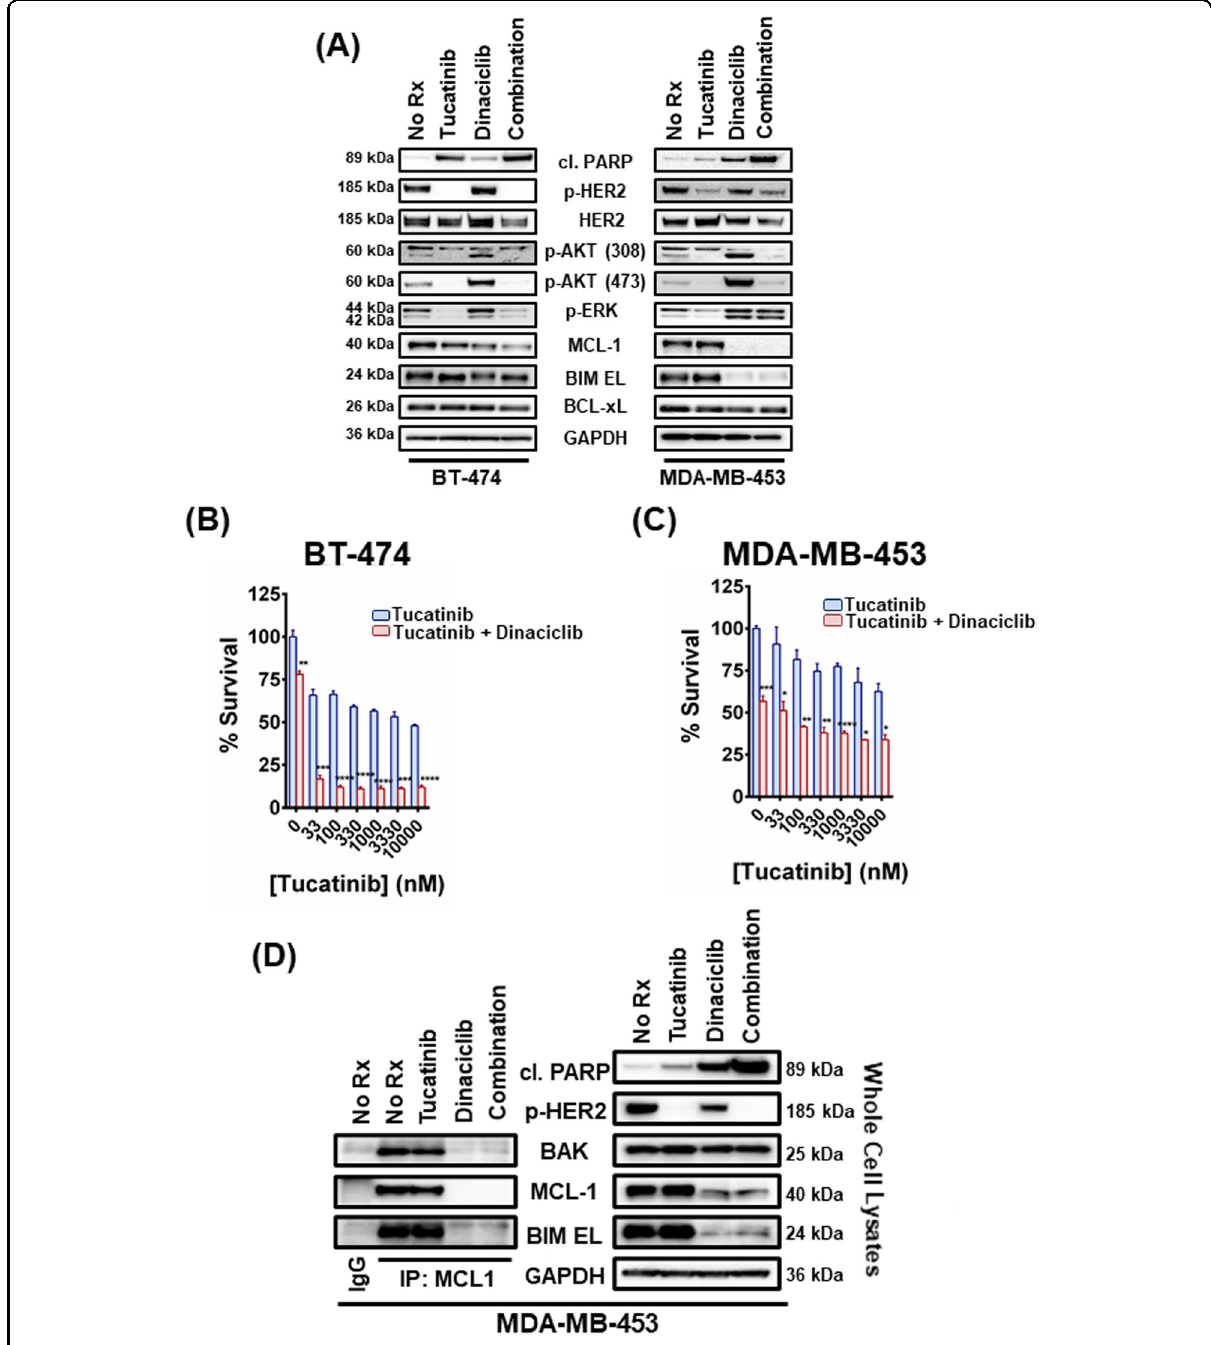
Fig. 3 Dinaciclib sensitizes HER2 -ampli fi ed breast cancer cells to tucatinib and liberates BAK from MCL-1. A BT-474 and MDA-MB-453 cells were treated with no drug, 1 μ M tucatinib, 100 nM dinaciclib, and their combination for 6 and 12 h, respectively. Whole-cell lysates were prepared, subjected to western blotting and probed for the indicated proteins. B BT-474 cells were treated with increasing concentrations of tucatinib and 100 nM dinaciclib for 24 h and the percentage of viable cells was determined. n = 3; error bars indicate ±SD. C MDA-MB-453 cells were treated with increasing concentrations of tucatinib and 100 nM dinaciclib for 48 h and the percentage of viable cells was determined. n = 3; error bars indicate ±SD. D MCL-1 complexes were immunoprecipitated from MDA-MB-453 cells following 12 h treatment with no drug, 1 μ M tucatinib, 100 nM dinaciclib, and their combination. An IgG-matched isotype antibody was served as an immunoprecipitation control. The interaction between MCL-1 and BIM EL/BAK proteins was investigated. For Fig. 3B, C two-tailed Student ’ s t test was performed; p values were corrected for multiple testing using the Bonferroni method. Differences were considered statistically different if p < 0.05. A p value < 0.05 is indicated by *, p < 0.01 by **, p < 0.001 by ***, and p < 0.0001 by ****. ( “ No Rx ” : No drug).